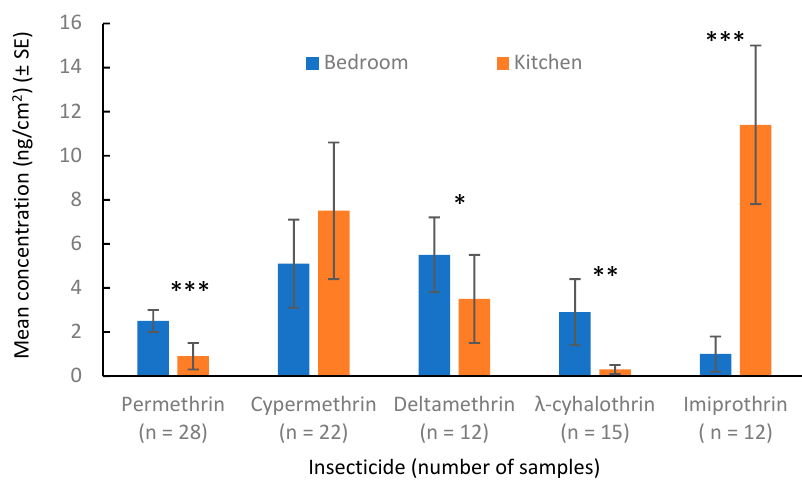
Figure 3. Distribution of the top five insecticides between bedrooms and kitchens in apartments where these insecticides were detected at 0 months (* p < 0.05, ** p < 0.01, *** p < 0.001). Among those apartments that were sampled both at 0 and 12 months, the mean number of insecticides in bedrooms (1.7 ± 0.2) was similar to that in kitchens (1.2 ± 0.2) (Wilcoxon signed-rank test, S = 125.5, p = 0.06) (Figure 4a). The mean number of insecticides detected per apartment was 2.5 mean total insecticide residue concentration per apartment was 10.6 ± 2.4 ng / cm 2 . Residue levels in the bedroom were similar to those in the kitchen (Wilcoxon signed-rank test, S = 68.5, p = 0.51) (Figure 5a).